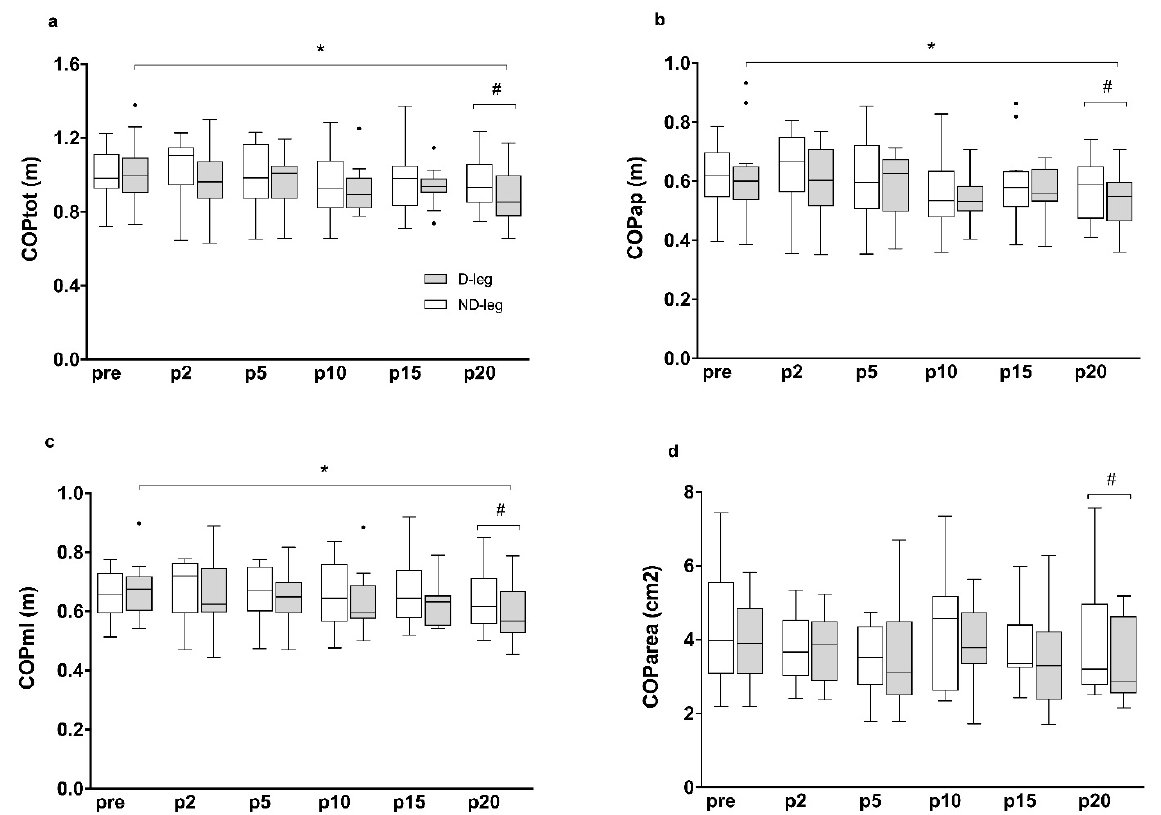
Figure 1. Boxplot representation of COP parameters in the D-leg and the ND-leg before (pre) and after (p2, p5, p10, p15 and p20) performing the warm-up routine. COPtot: total COP length ( a ); COPap: COP length in the anteroposterior direction ( b ); COPml: COP length in the mediolateral direction ( c ); COParea: COP ellipse area ( d ); Assessments were performed before (pre), 2 min (p2), 5 min (p5), 10 min (p10), 15 min (p15) and 20 min (p20) after the completion of the warm-up. Small circles indicate data points beyond the whiskers. *: significant difference between two assessment times; #: significant difference between the D-leg and the ND-leg ( p < 0.05).